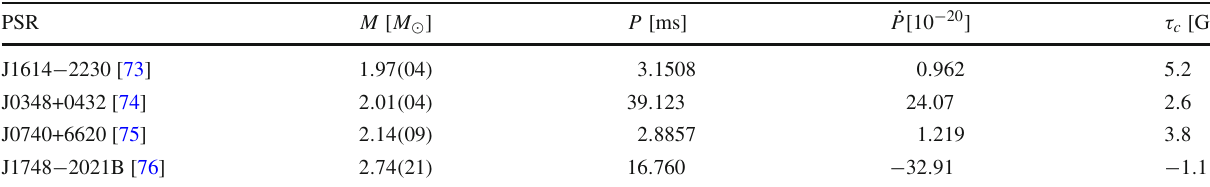
Table 1 Some of most massive pulsars, with their measured P and ˙ P values and derived characteristic ages τ c = P / 2 ˙